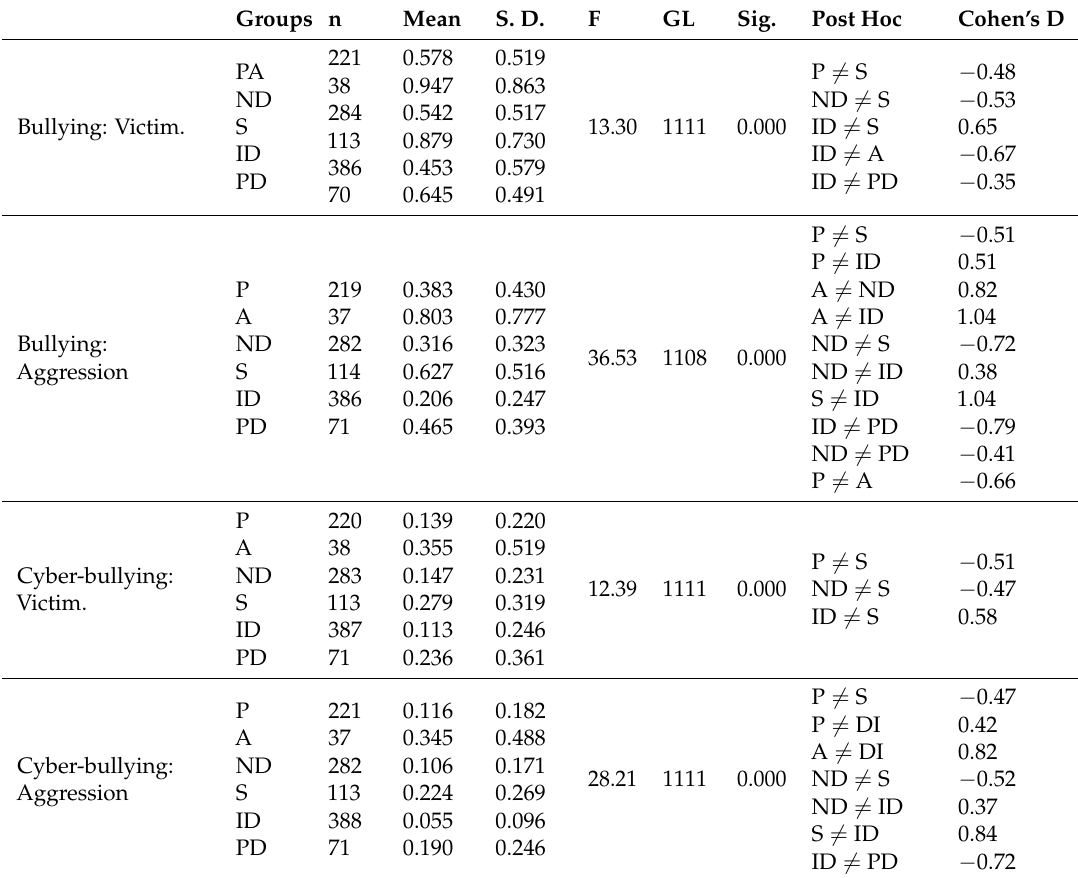
Table 3. Differences in involvement in bullying and cyberbullying, according to the parents’ educational profile. Groups n